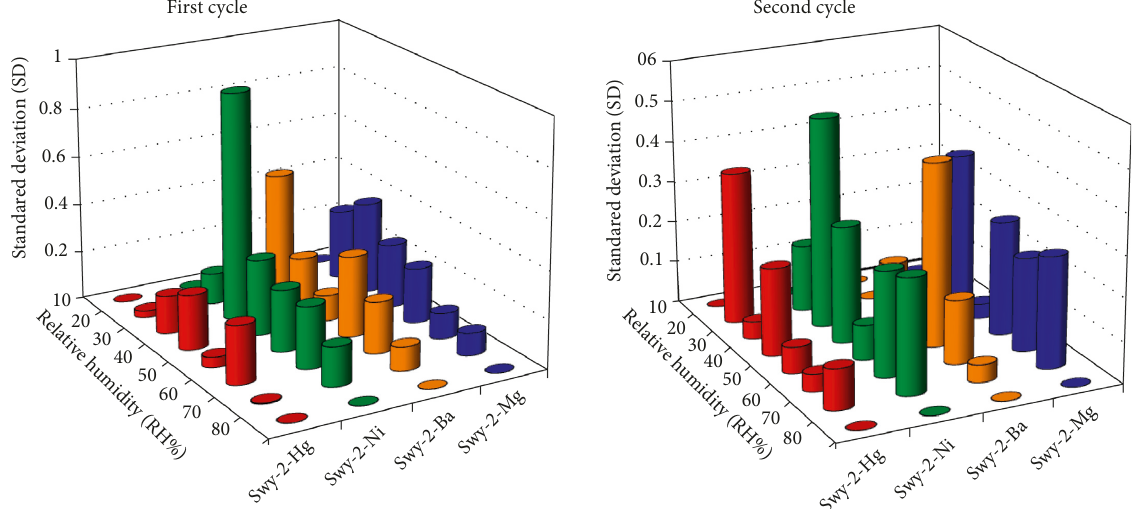
Figure 10: Stacked histogram of the hydration SD for the montmorillonite exchanged with divers cations during the hydration- dehydration